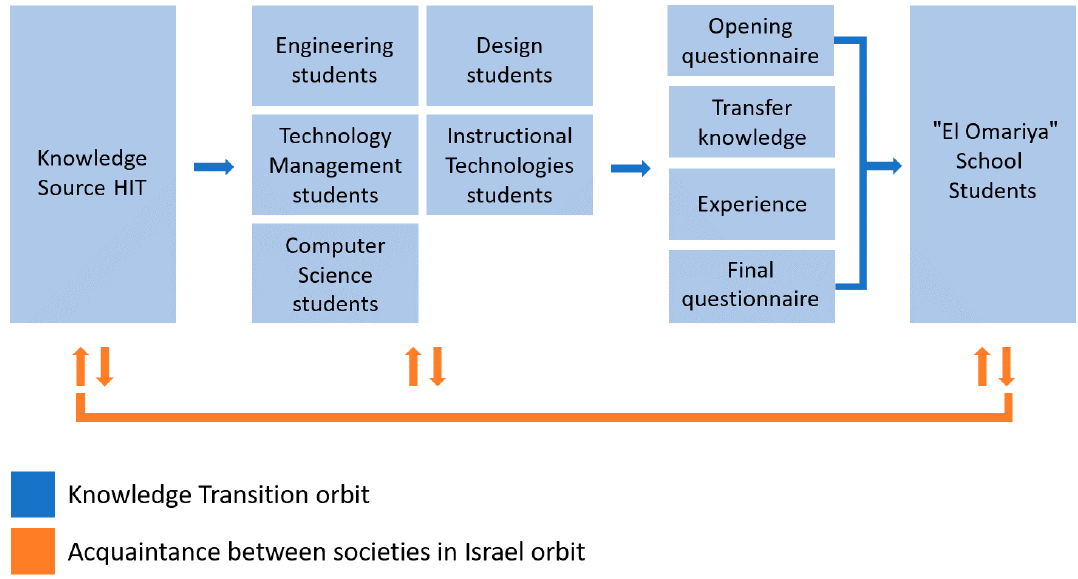
Figure 1. The course “Green Ambassador” approach that included mutual fertilization between the students and the pupils, in which the students got familiar with the Arabic society and passed their environmental knowledge to the pupils.